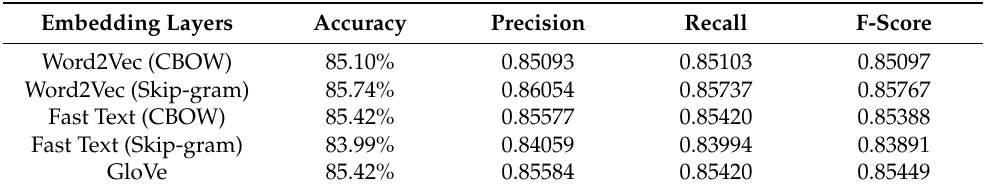
Table 9. The Median Values Obtained using One Dense Layer.